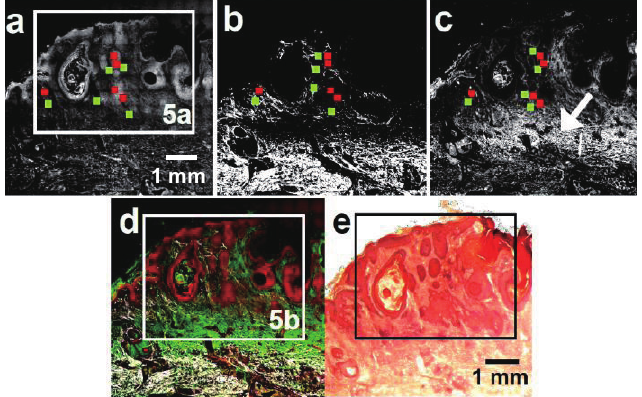
Figure 4. CARS, SHG, TPEF (gray scale) multimodal images (CARS: red; TPEF: green; SHG: grays) of a squamous cell carcinoma (SCC). The red (tumorous) and green (non-tumorous) squares locate the position of the 100 × 100 pixel sized areas selected for statistical analysis. ( a ) CARS overview image of the SCC; ( b ) Corresponding SHG image. Analogous to BCC, SCC tissue shows a negligible SHG signal; ( c ) TPEF image of the same region. Analogous to BCC tissue, SCC tumor nests show a slightly increased TPEF intensity compared to the adjacent dermal tissue. The white arrow points towards a layer of accumulated elastin fibers referred to as solar elastosis; ( d ) Multimodal image combining the information of Figure 4a – c; ( e ) H&E stained section of the SCC.